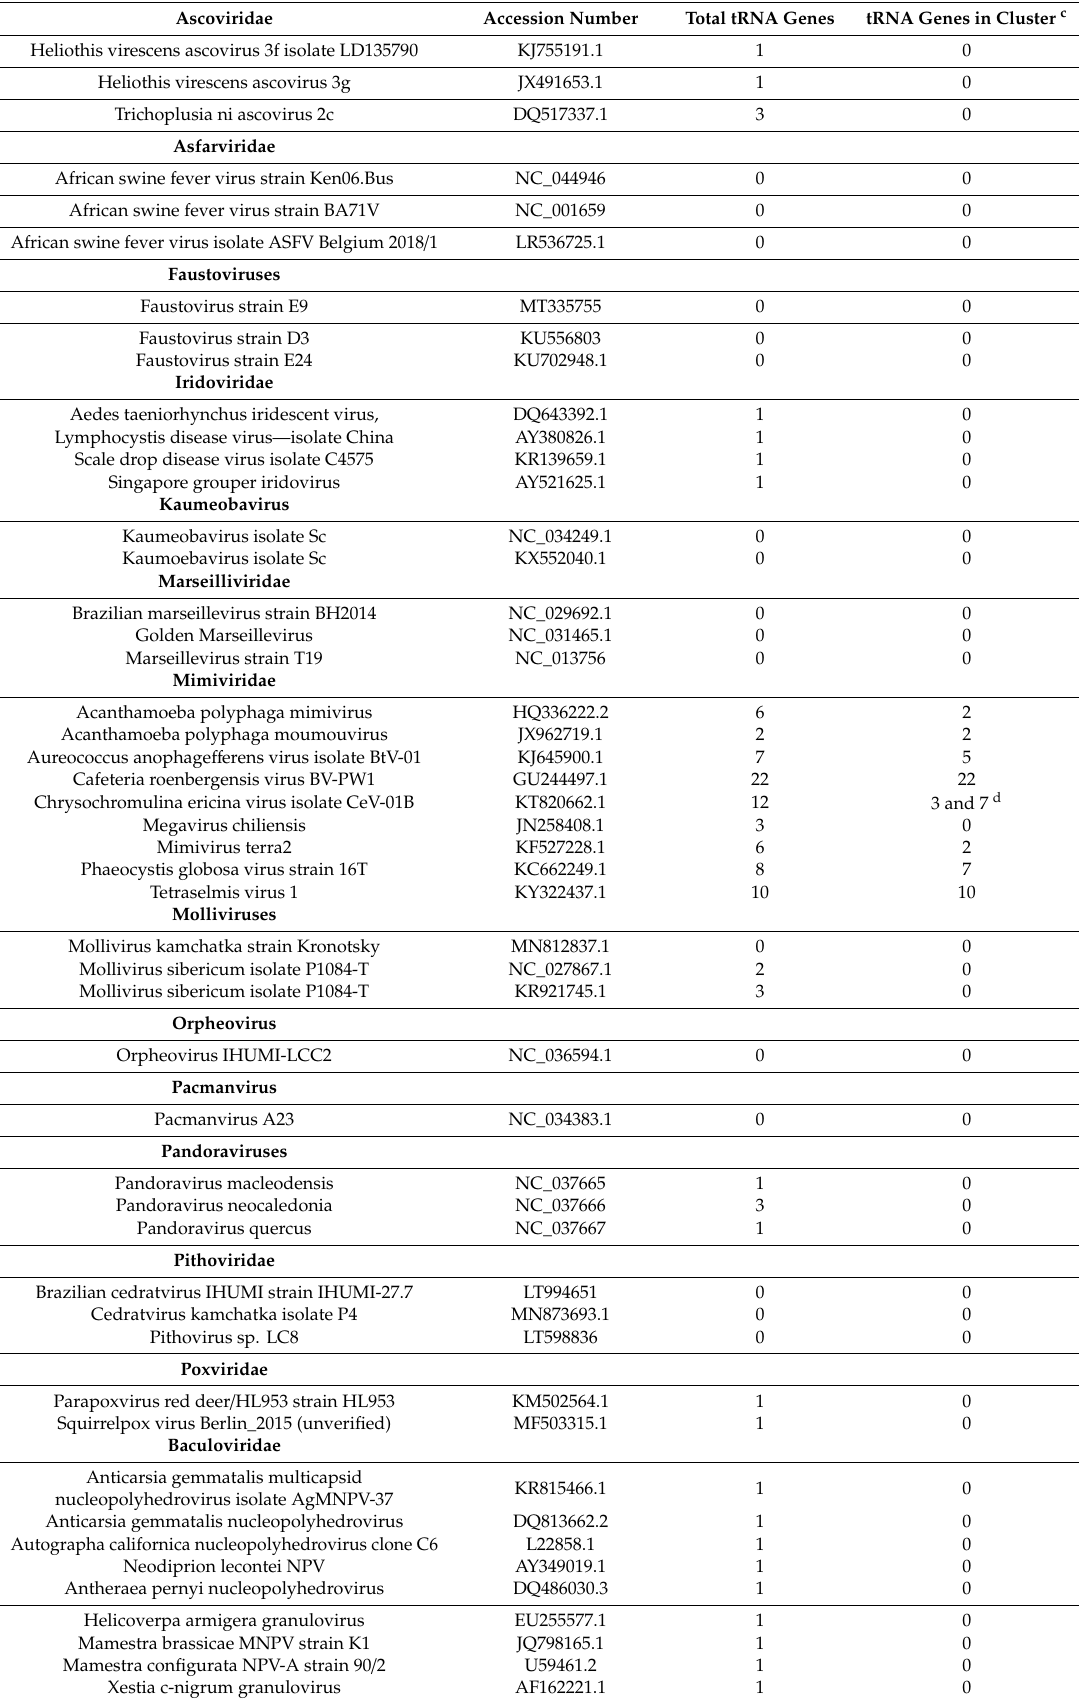
Table 7. Total tRNA genes and clusters of representative large DNA viruses a,b